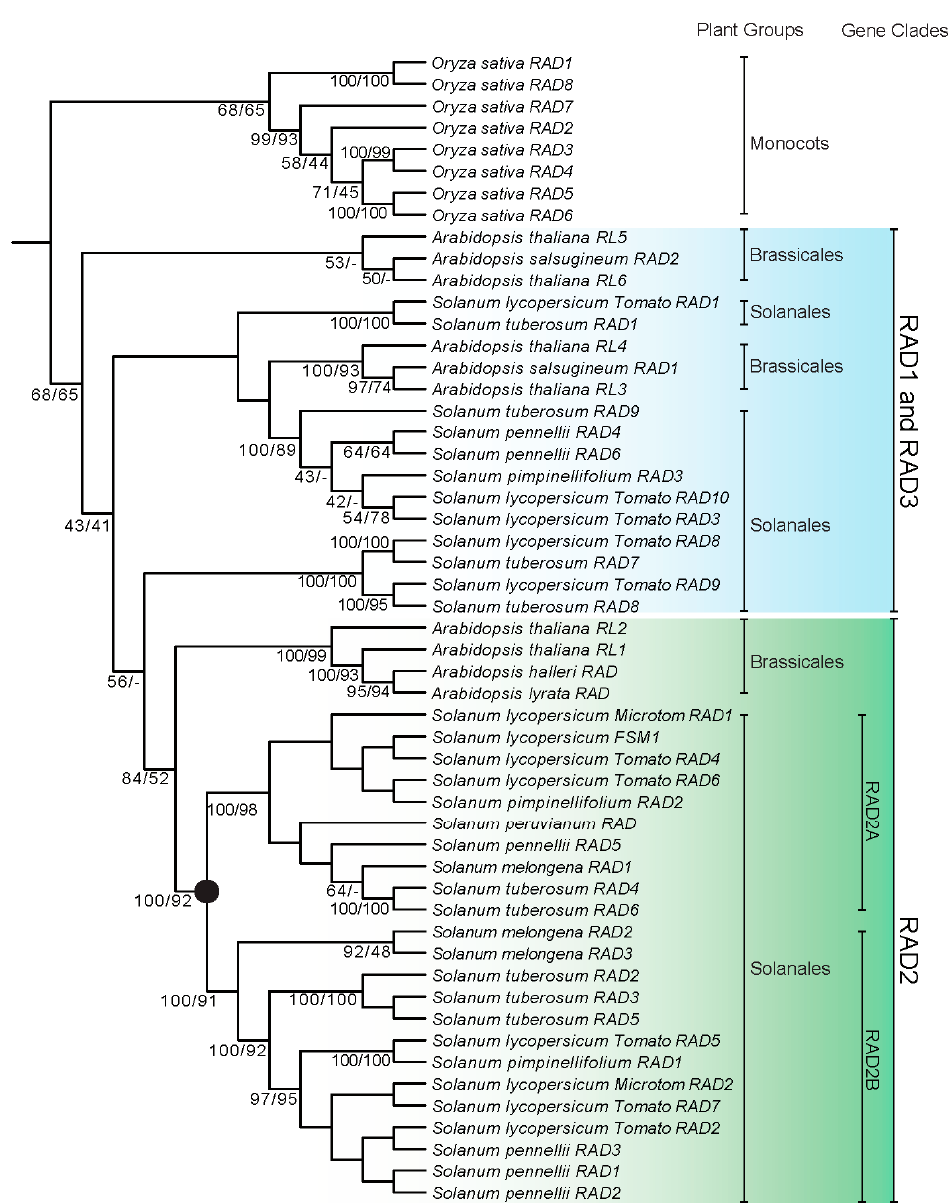
Figure 1. Phylogeny of I-box-binding/RADIALIS- like genes of four species of Arabidopsis , six species of Solanum , and Oryza sativa based on Bayesian and maximum likelihood (ML) inferences. All sequences from O. sativa formed a monophyletic clade was used to root the phylogeny. Based on the clade defined by Boyden et al. (2012), [21], only the RAD2 clade was monophyletic and contained sequences from Arabidopsis and Solanum . There are two paralogs in the RAD2 clade, i.e., RAD2A and RAD2B, which resulted from a gene duplication that Arabidopsis was not involved. RAD1 and RAD3 are paraphyletic. Bayesian posterior probabilities and bootstrap frequencies ≥ 40% depicted close to the branches, respectively.